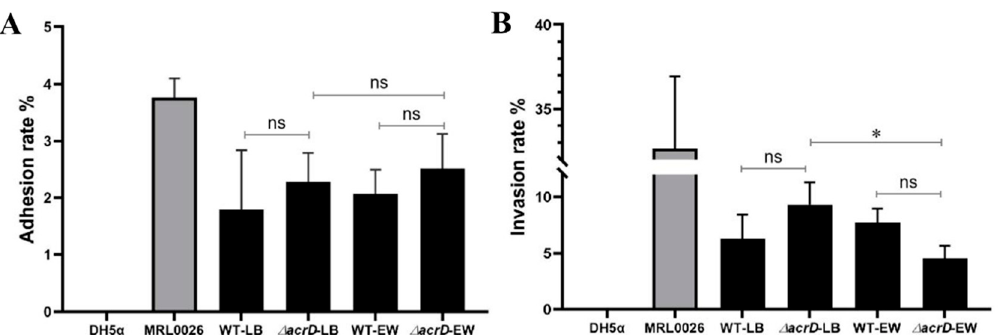
Figure 4. Adhesion ( A ) and invasion ( B ) ability of Caco-2 cells by S. Enteritidis wild type (WT), Δ acrD mutant and control strains in egg white (EW) and LB broth at 37 °C. Non-adherent/invasive E. coli DH5 α and highly invasive Salmonella MRL0026 were used as negative and positive controls, respectively. Mean values and standard deviations were calculated from three replicates. Asterisk (*) indicates that there is a significant difference between the invasion rate of Δ acrD in egg white and that in LB broth ( p < 0.05). ns, no significant difference.